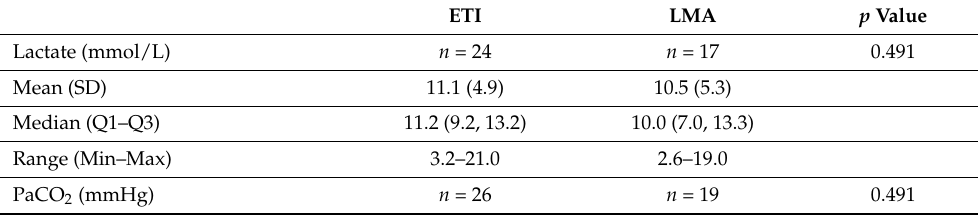
Table 2. Patient characteristics at hospital admission. The presented results correspond to data obtained after propensity score matching for one of the five imputed datasets that were generated following multiple imputation by chained equations (mice). Abbreviations: PaCO 2 = partial pressure of carbon dioxide, PaO 2 = partial pressure of oxygen, SD = standard deviation, Q1 = first quartile, Q3 = third